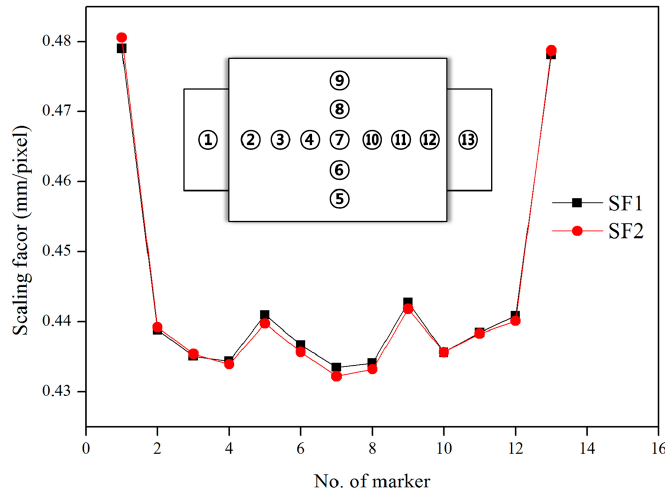
Figure 6. Comparison of the scaling factors calculated by the marker and the scaling factor map, respectively.